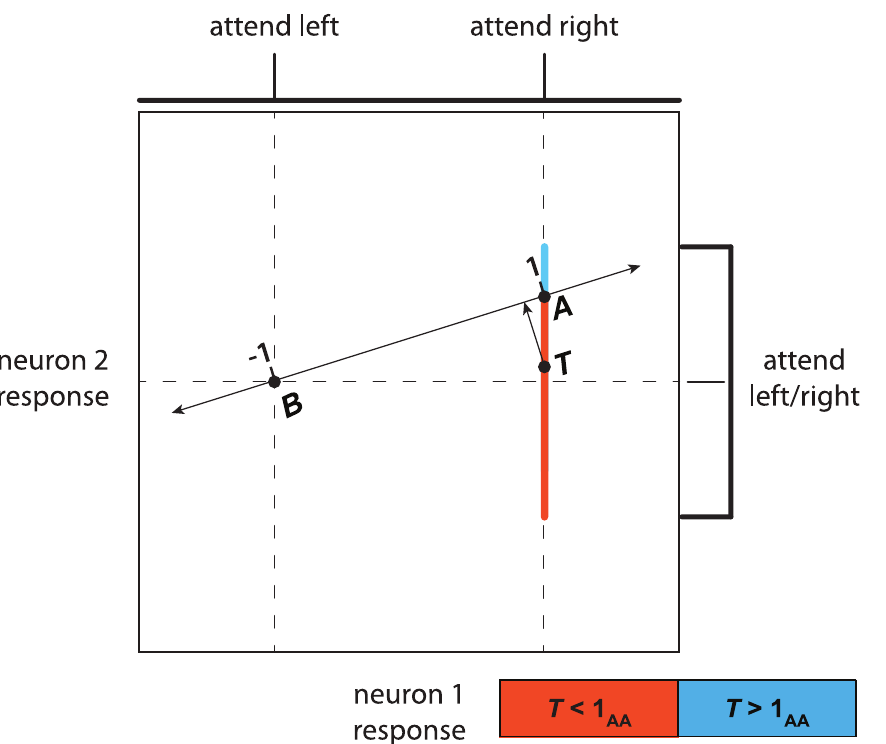
Fig 2. Multidimensional regression. The responses of two neurons in two conditions, attend-left and attend-right. Neuron 1 ’ s response to attend-right is greater than that to attend-left, and its responses in both conditions are noiseless, as illustrated by the impulse functions (top) and vertical dashed lines. The response of neuron 2 is noiseless in the attend-left condition, but drawn from a uniform distribution in the attend-right condition (impulse function and spanned range on right). The attention axis (double-sided arrow) connects samples A and B .